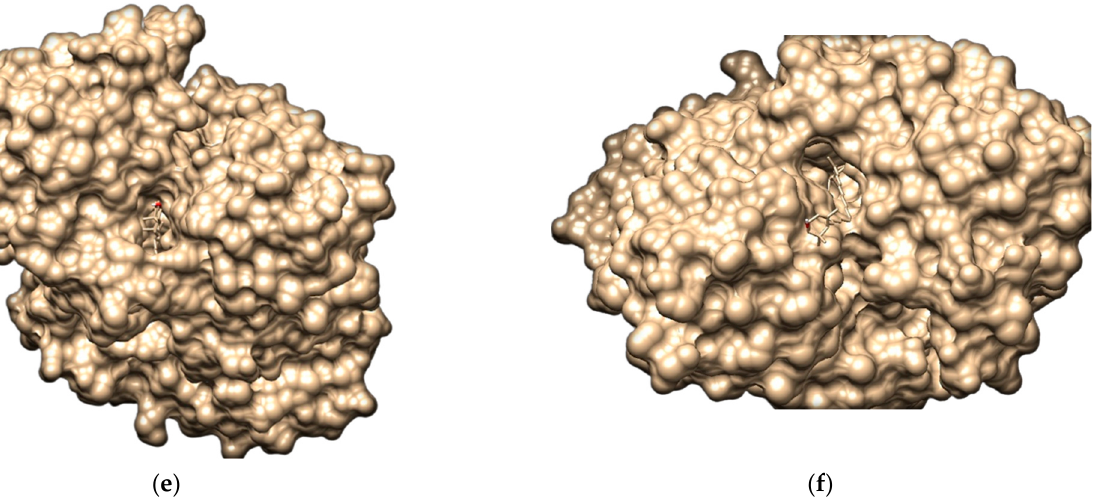
Figure 11. Molecular docking analysis: ( a ) pose view of CALHM1 with betacarotene; ( b ) pose view of CALHM1 with betasitosterol; ( c ) pose view of CALHM1 with quercetin; ( d ) pose view of CALHM1 with stigmasterol; ( e ) pose view of CALHM1 with xanthophyll; ( f ) pose view of CALHM1 with dihydroquercetin.